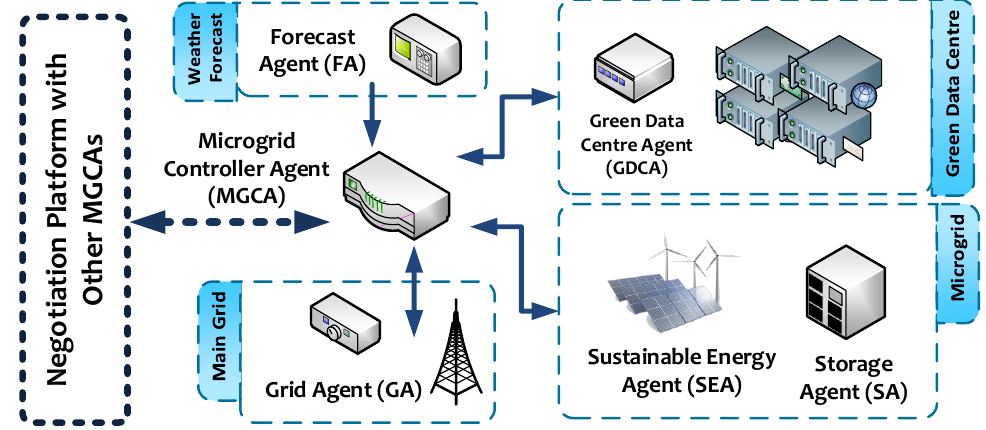
Figure 1. The structure of the agent-based management of the microgrid including the green data